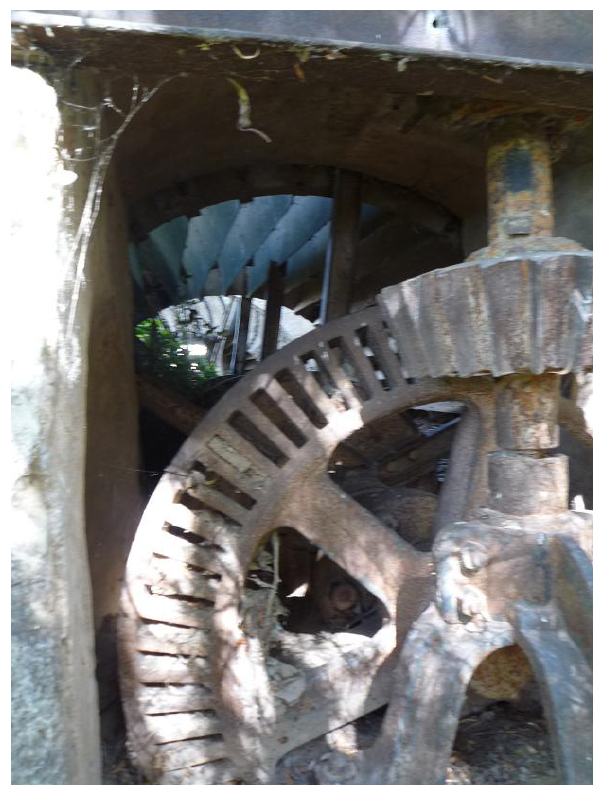
Figure 7: Original mechanism of